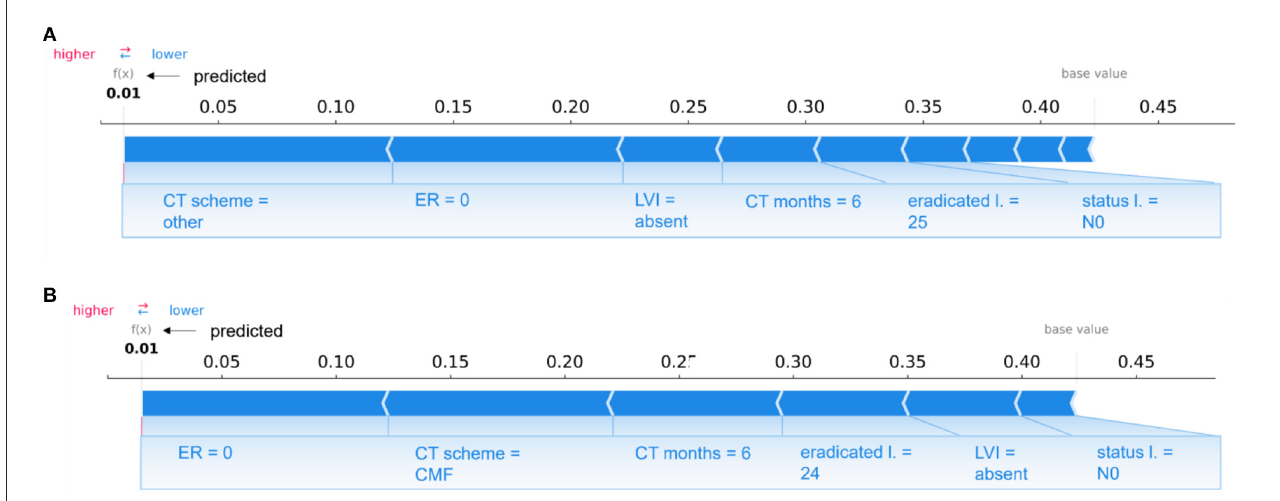
FIGURE8 Comparison of individual explanations between a patient correctly classified and confounding patient. (A) Correctly classified patient (non-IDE class) and (B) wrongly classified patient (real class: IDE; predicted class: non-IDE) by the 10-year predictive model. (A, B) Representation of the additive Shapley values: red color indicates a positive contributions, while blue a negative